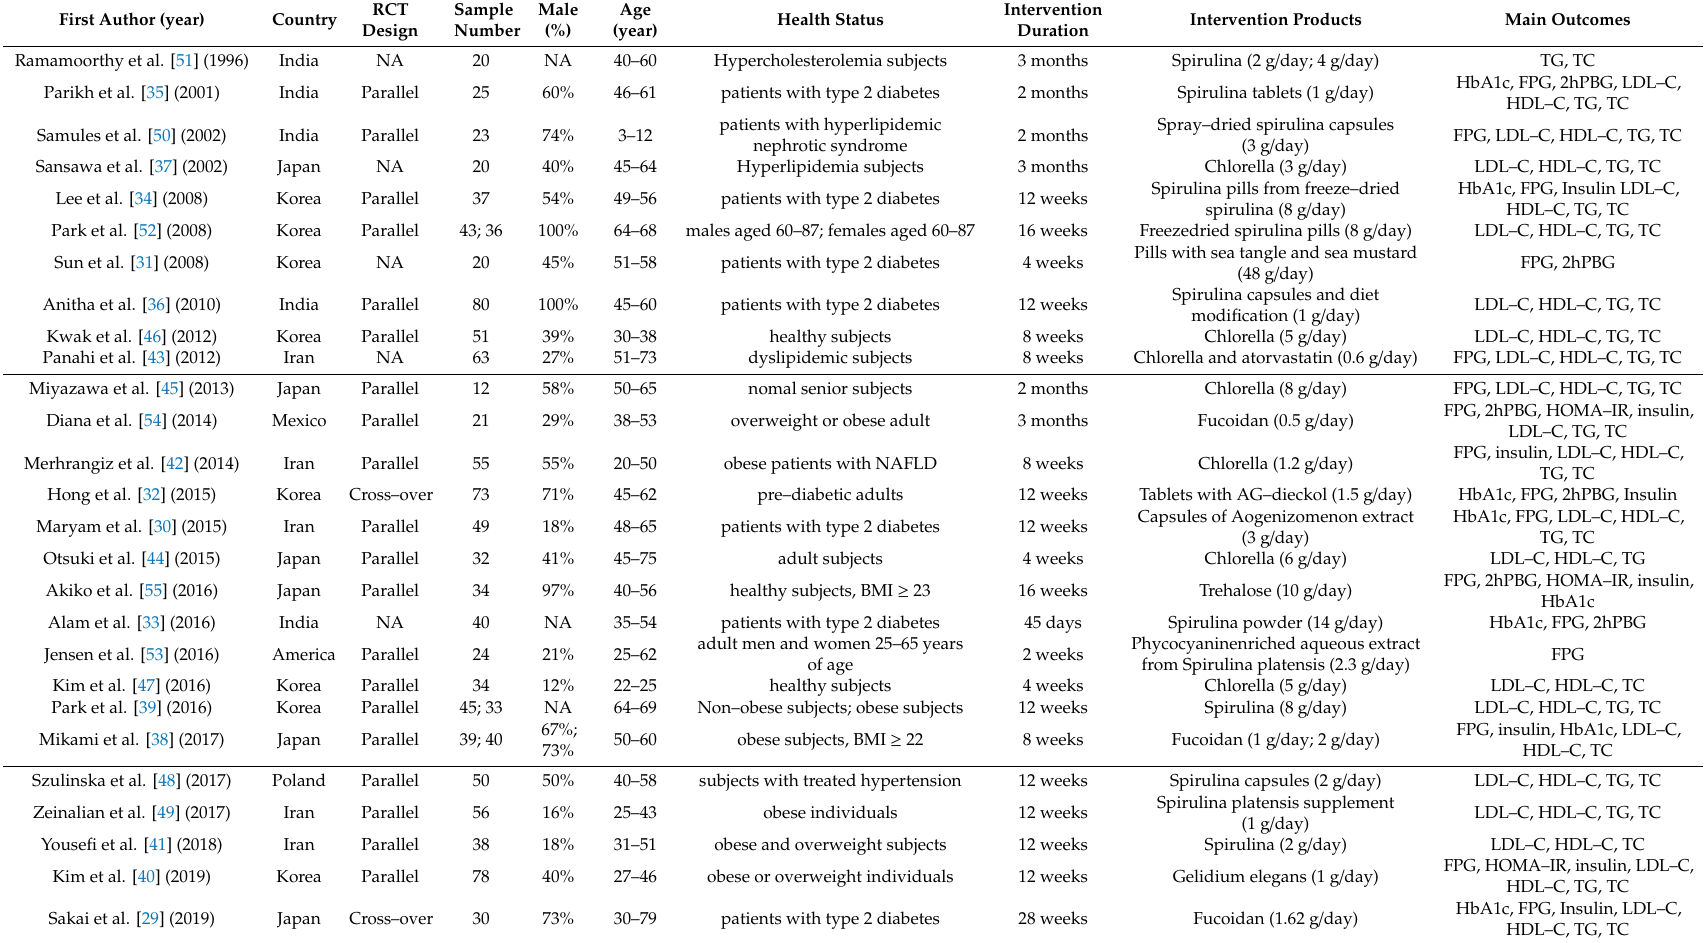
Table 1. Characteristics of the included randomized controlled trails